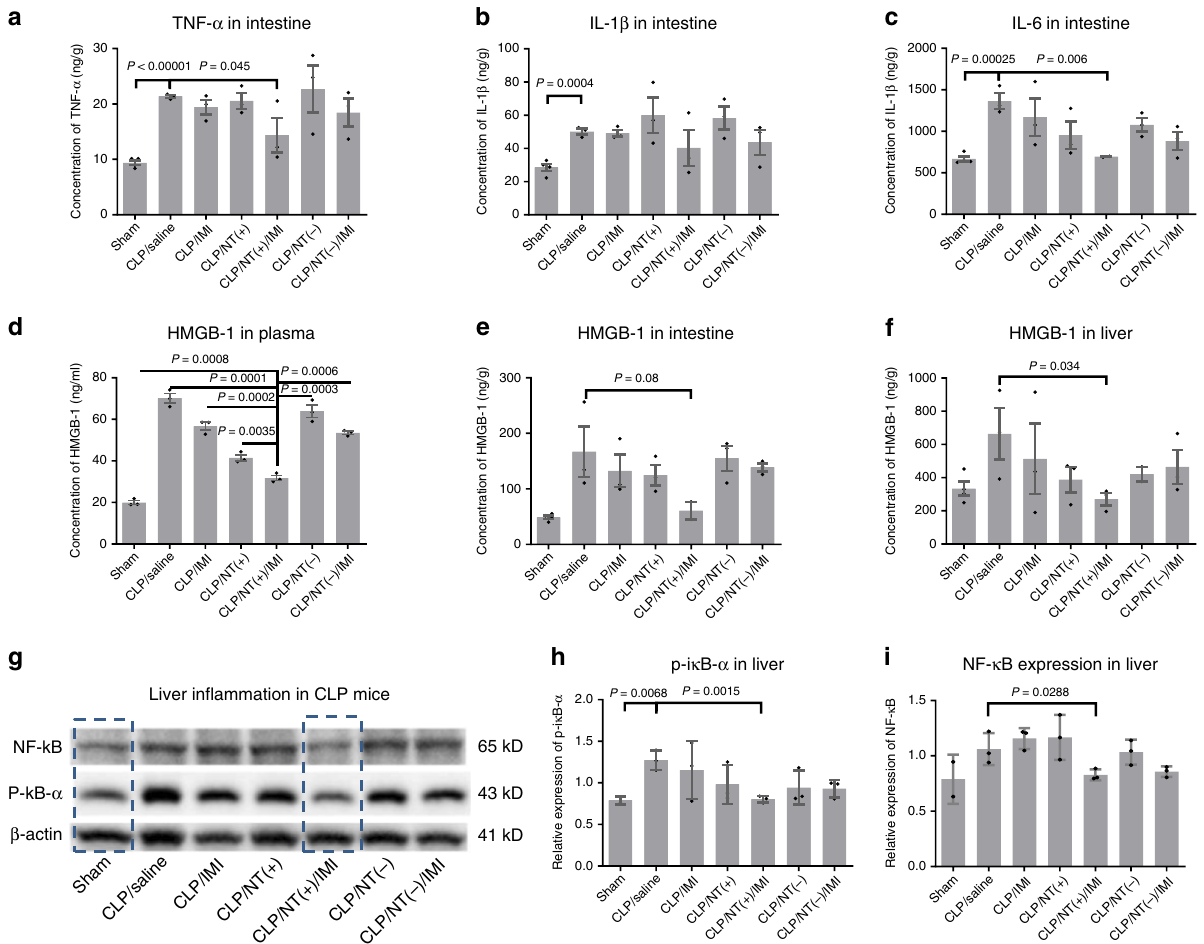
Fig. 8 Reduced tissue damage and organ in fl ammation in sepsis survivor. a – c Critical cytokine expression levels in the intestine. d – f HMGB-1 expression levels in the plasma, liver, and intestine as a DAMP indicator for tissue damage. g – i The expression levels of NF- κ B and its activation via phosphorylation of I κ B- α in the liver as an indicator of remote organ in fl ammation ( n = 3, mean ± SEM. Statistical signi fi cance was measured by unpaired one-sided Student ’ s test). Source data are available in the Source Data fi